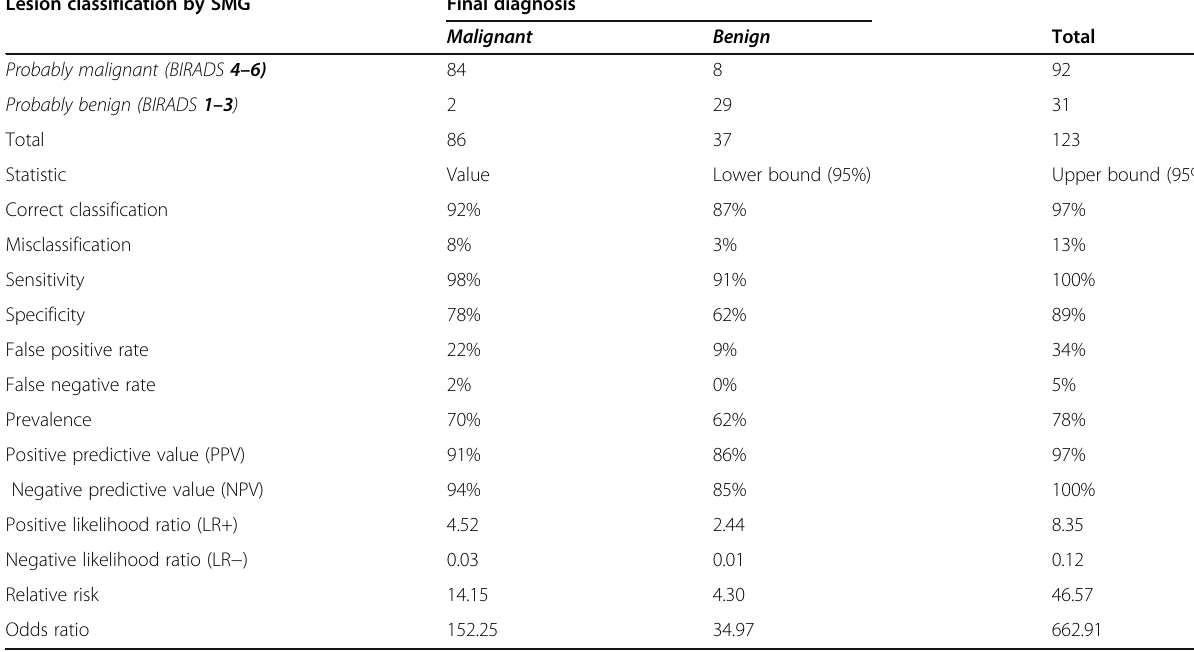
Table 7 Diagnostic accuracy of CESM in the whole study cohort versus the result of biopsy or follow-up as the gold standard for lesion